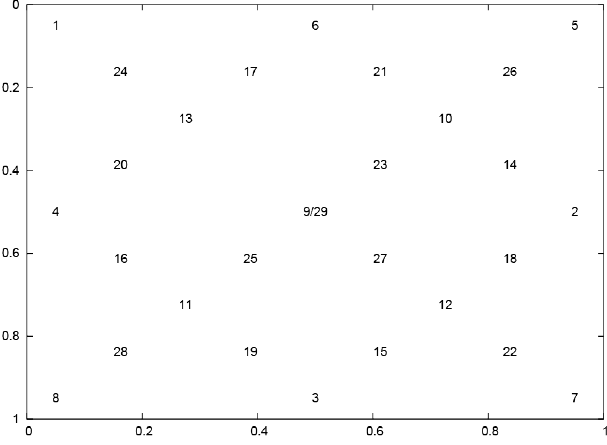
Figure 1. Layout of stimuli applied during experiments– based on the universal scale—the top–left corner of the screen is represented by (0.0, 0.0) coordinates and the bottom–right corner by (1.0, 1.0)